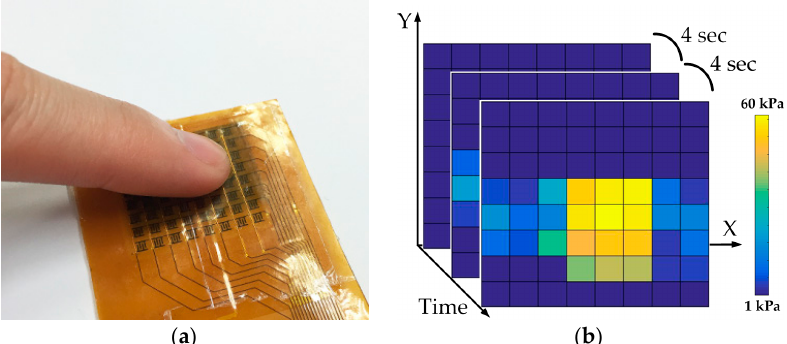
Figure 12. Tongue position detecting demonstration by the prototype module: ( a ) Fingertip pressing on the array; ( b ) corresponding force images recorded in continuous time frames using an interval of 4 s.